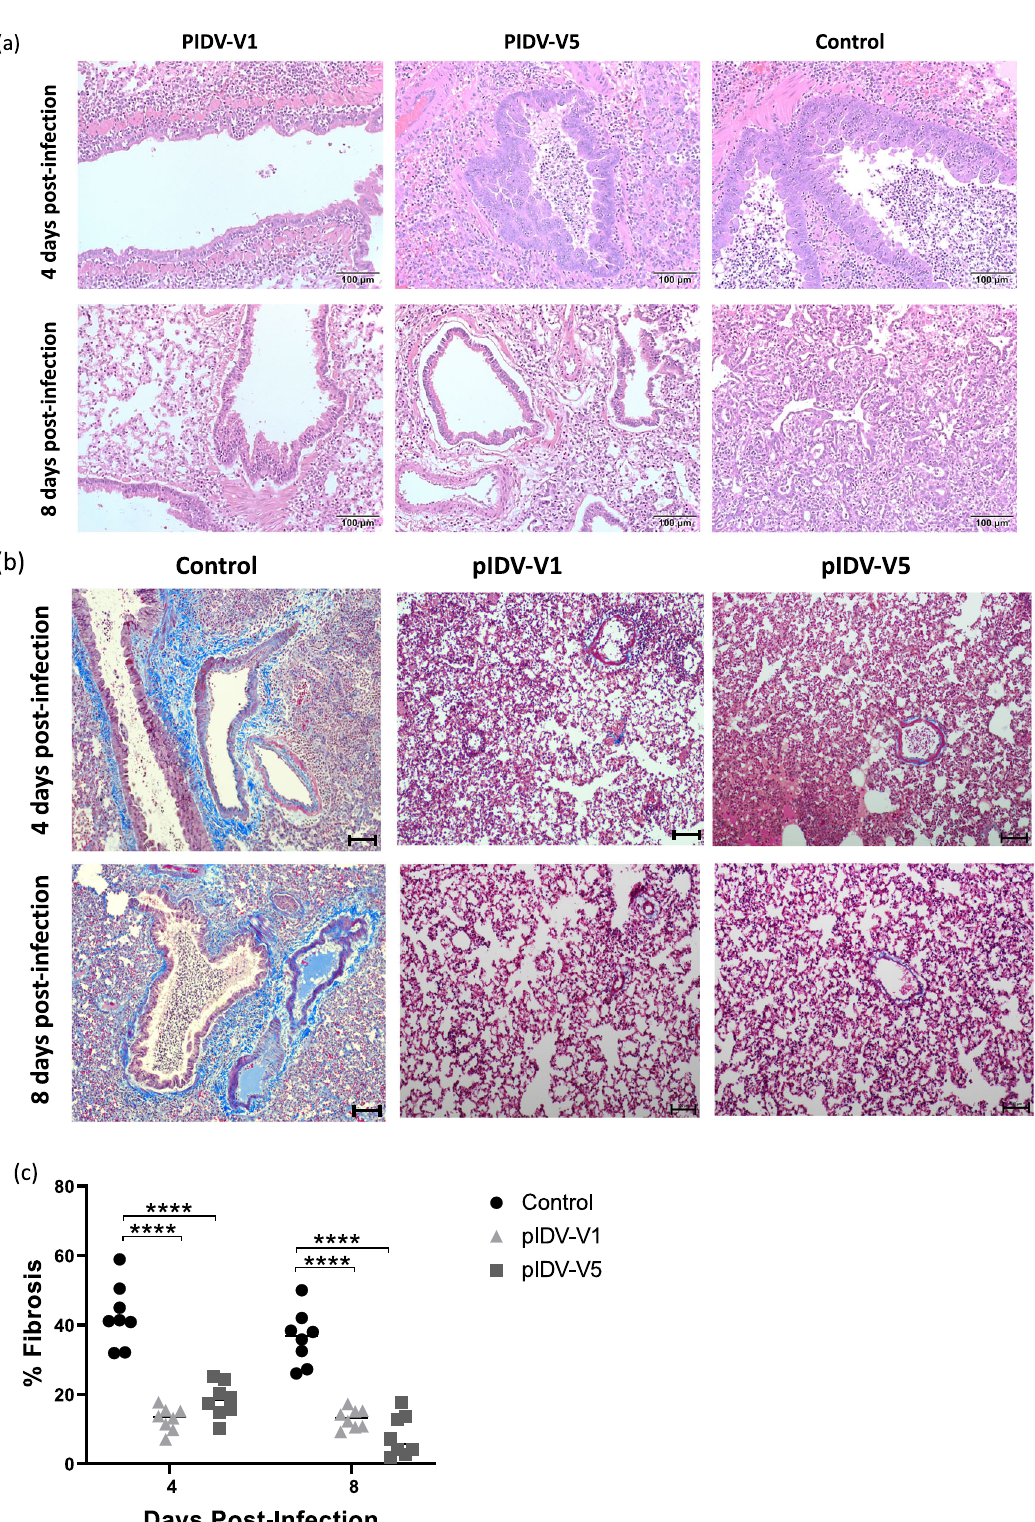
Fig. 6 Lung pathology in vaccinated and unvaccinated hamsters. a Representative HE stain (10X magni fi cation, Scale bar = 100 um) in PIDV- V1, PIDV-V5, and control groups at 4 and 8 days post-infection ( n = 4 per group). b Representative Masson ’ s trichrome staining (10X magni fi cation, Scale bar = 100 um). Collagen is indicated by areas stained in blue. c Quanti fi cation of fi brosis (collagen staining) presented as mean percentage fi brosis of total lung tissue. Two-way- ANOVA- Dunnett ’ s multiple comparisons test was performed (Control vs. PIDV-V1 day 4, **** p < 0.0001, Control vs. PIDV-V5 day 4 **** p < 0.0001, Control vs. PIDV-V1 day 8, **** p < 0.0001, Control vs. PIDV-V5 day 8 **** p < 0.0001). Scale bar represents 100 μ